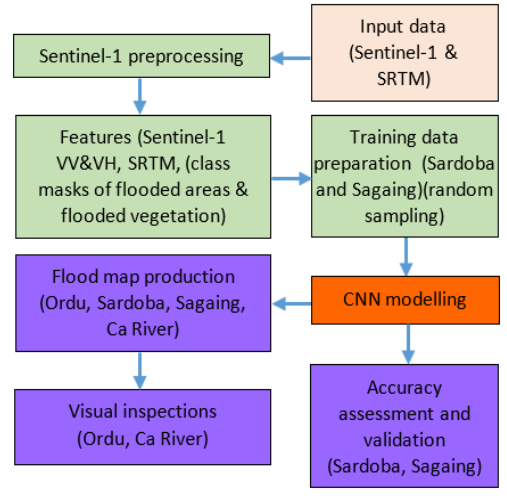
Figure 1 . The overall methodological